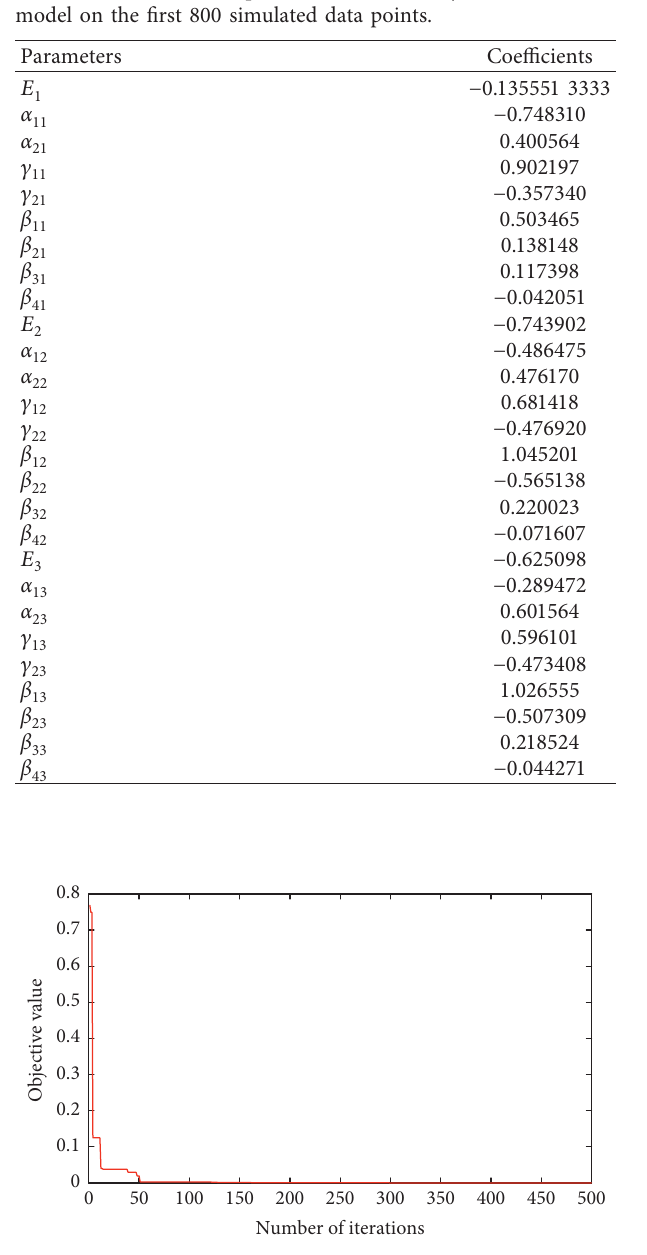
Figure 18: The MSFE obtained by JADE with archive .